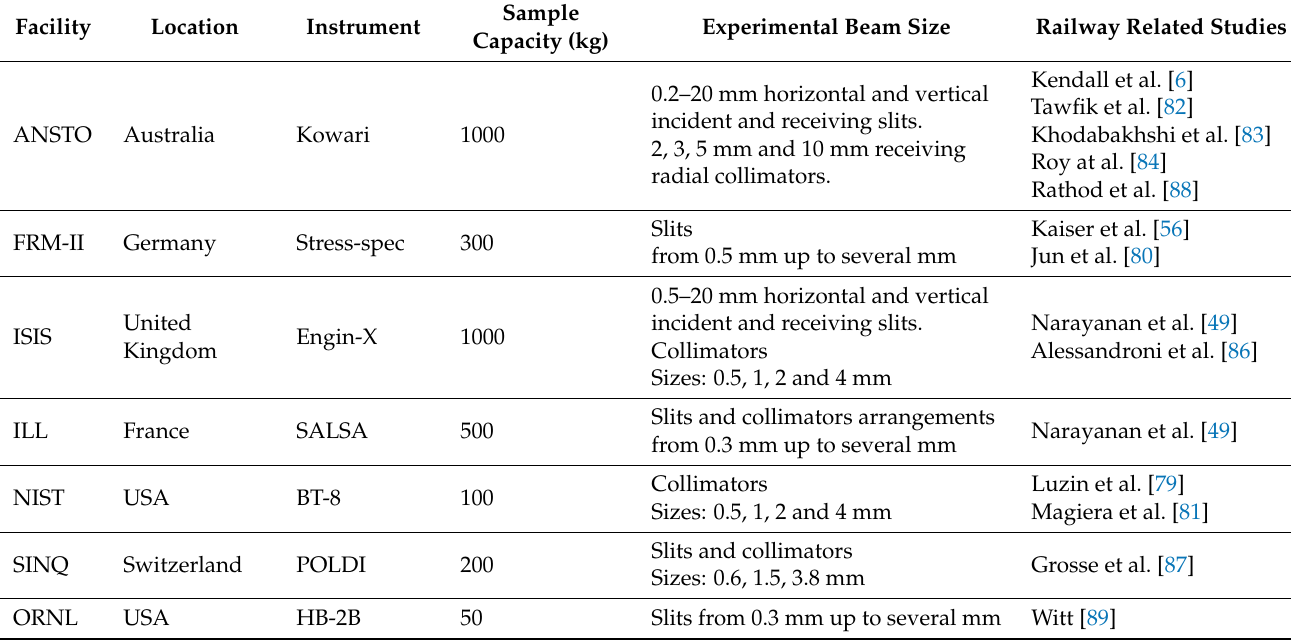
Table 2. Neutron facilities with rail component residual stress measurement